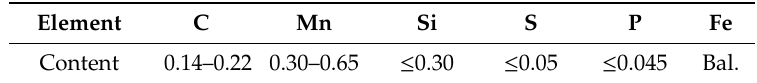
Table 2. Chemical composition of Q235a (wt